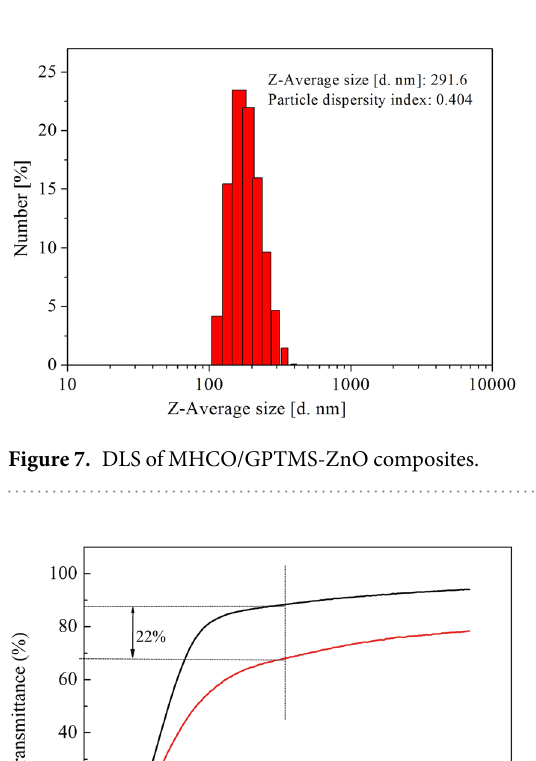
Figure 6. TEM image of MHCO/GPTMS-ZnO composites.